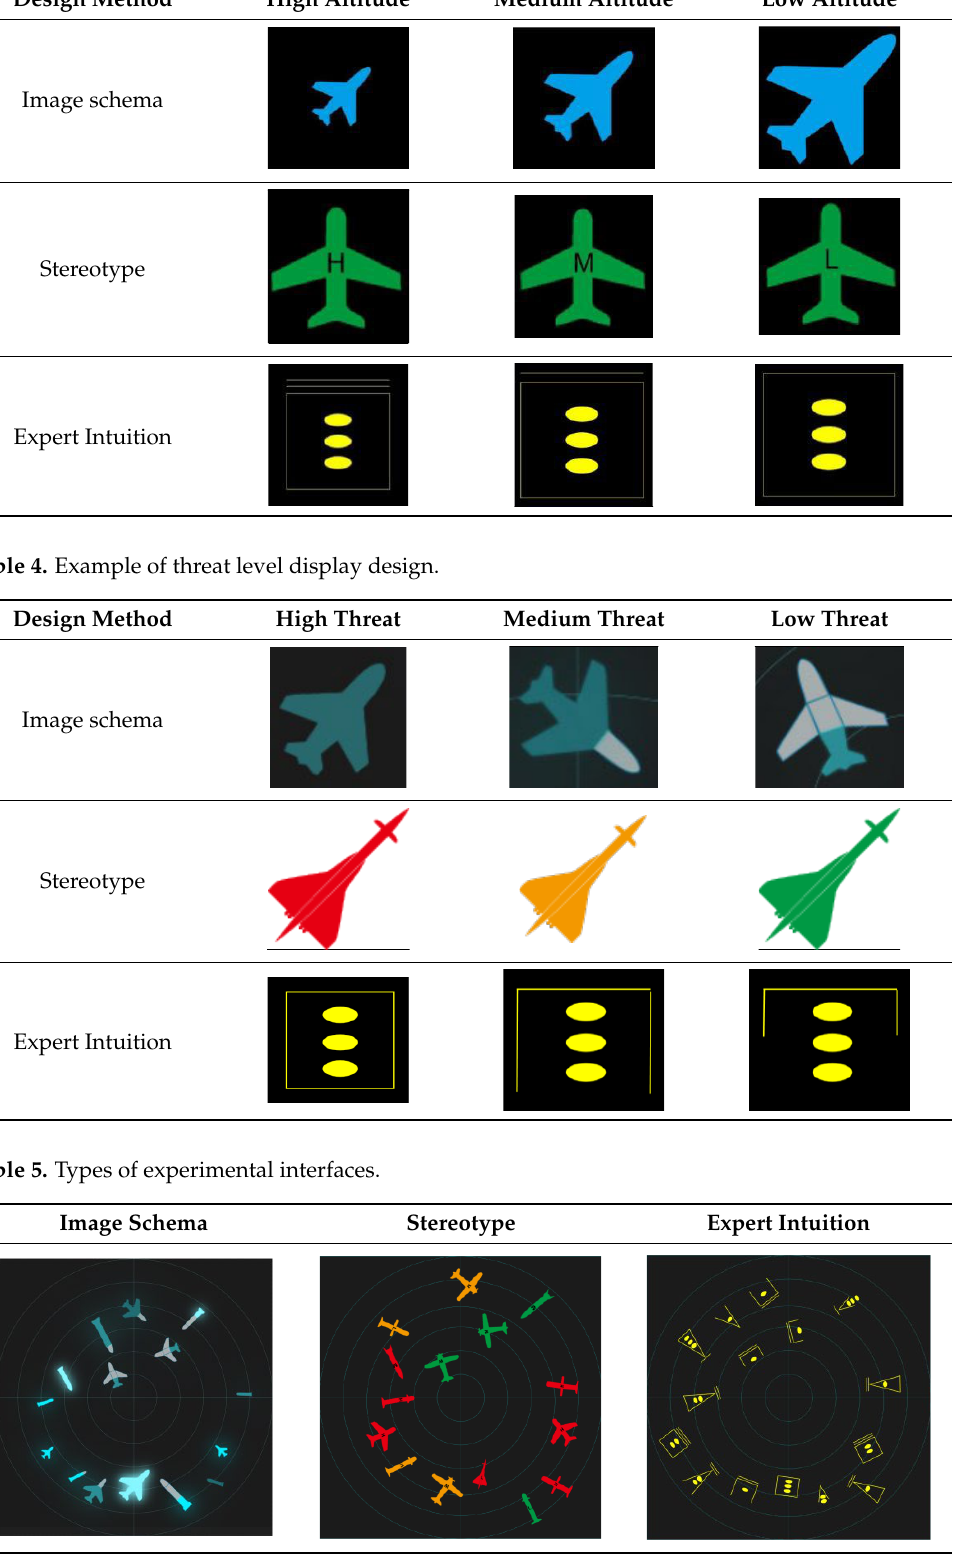
Table 3. Example of height display design.